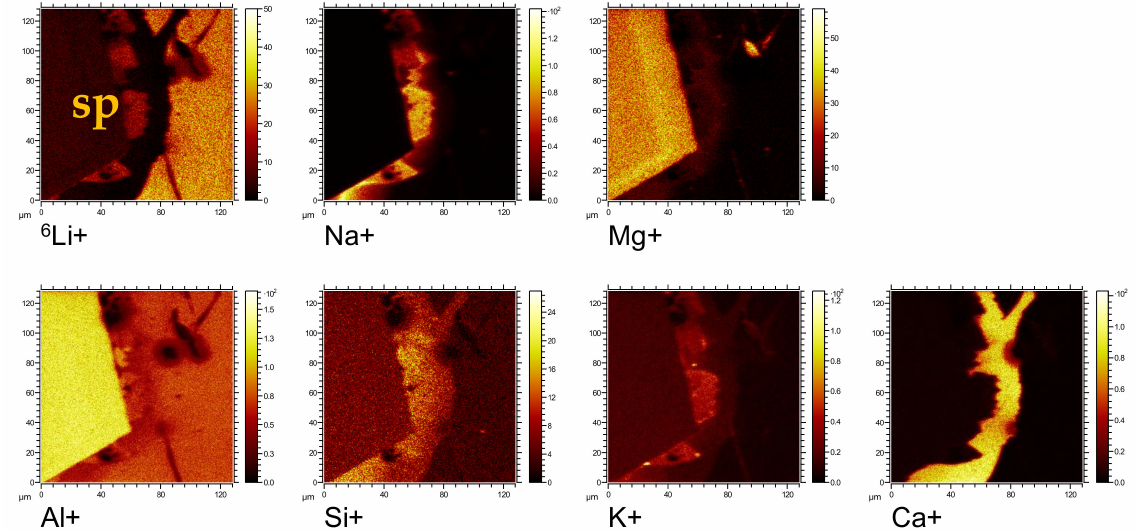
Figure 4. Details of the lateral intensity distributions of selected positive isotope-resolved secondary ion signals of a spinel crystal (sp).